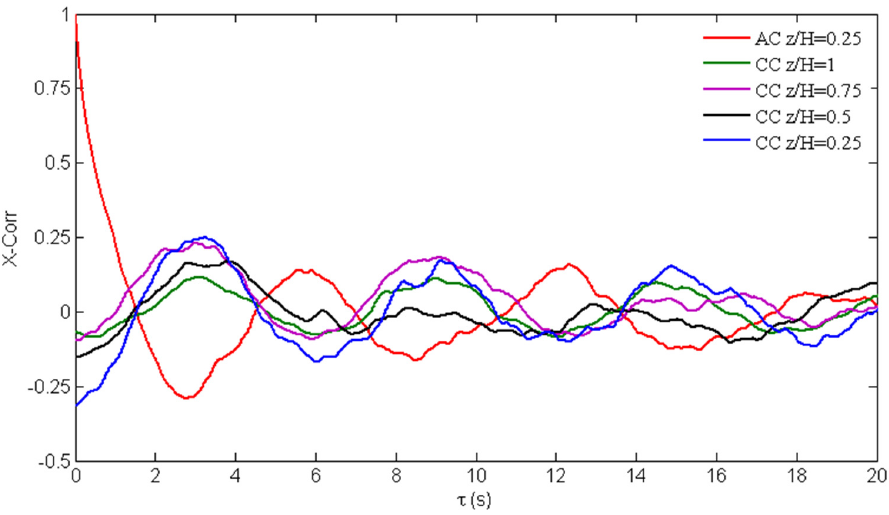
Figure 7. Auto- and cross-correlation-coefficients for fluctuating velocity on opposite sides of the cube at x/H = 1 and y/H = ±1 and 0.25 ≤ z / H ≤ 1. cube at x/H = 1 and y/H = ± 1 and 0.25 ≤ z / H ≤